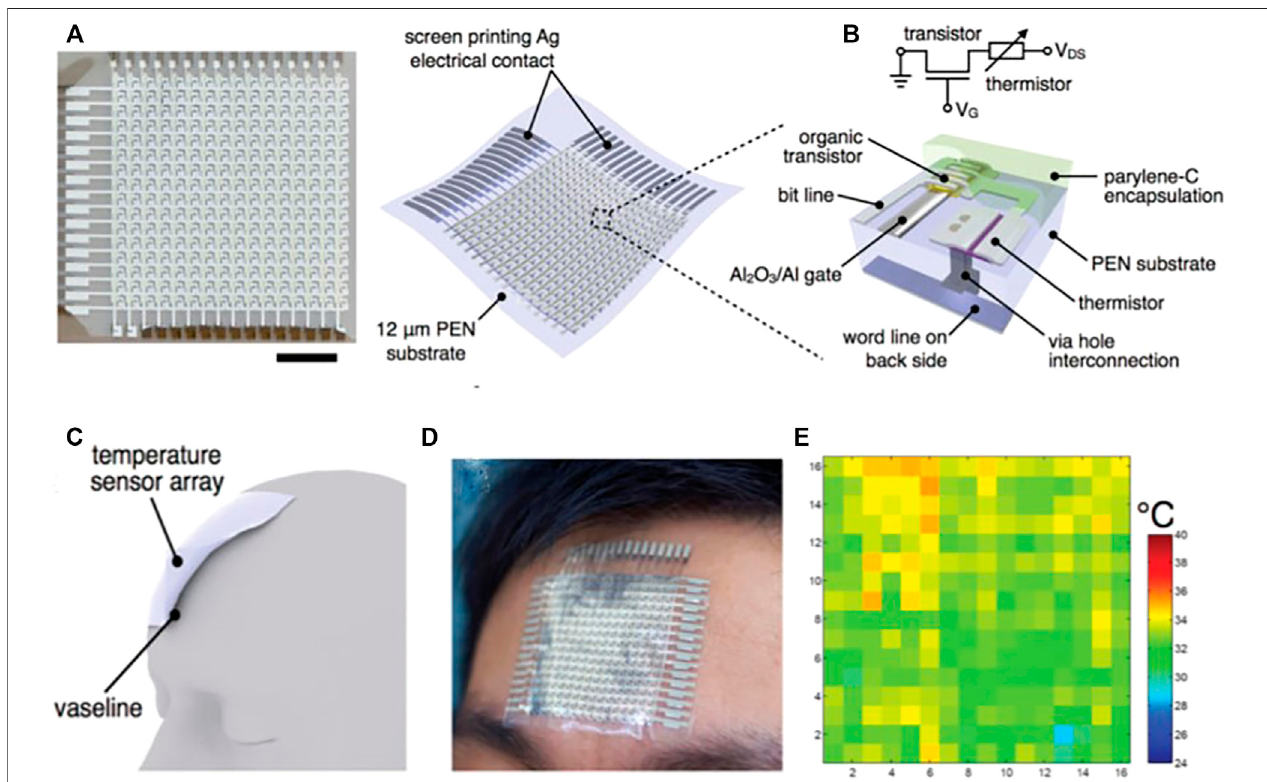
FIGURE 5 | (A) Optical image and schematic drawing of fl exible temperature sensor array (the scale bar is 10 mm). (B) Schematic of a fl exible temperature sensor unit. (C) Schematicof fl exibletemperaturesensorarrayattachedtotheforehead. (D) Opticalimageofthe fl exibletemperature sensorarray. (E) Correspondingmapping of distribution of the fl exible temperature sensor array on the forehead (Ren et al.,